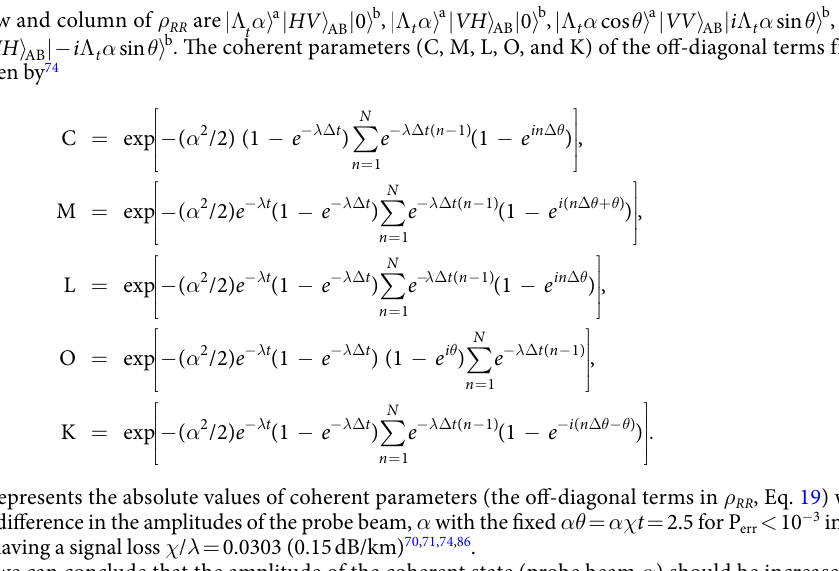
km), according to our analysis via the master equation (Eq.